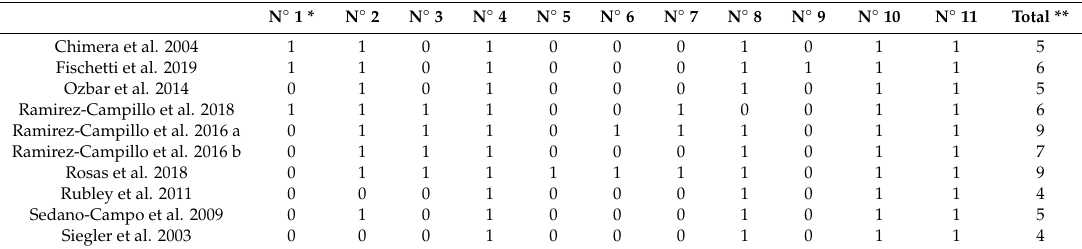
Table 4. Physiotherapy Evidence Database (PEDro) scale ratings.